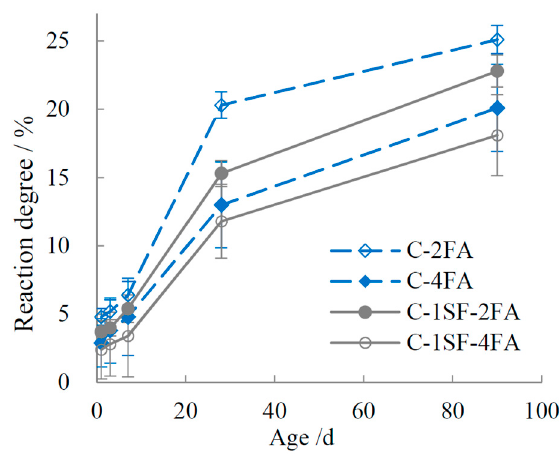
Figure 4. Reaction degree of FA.